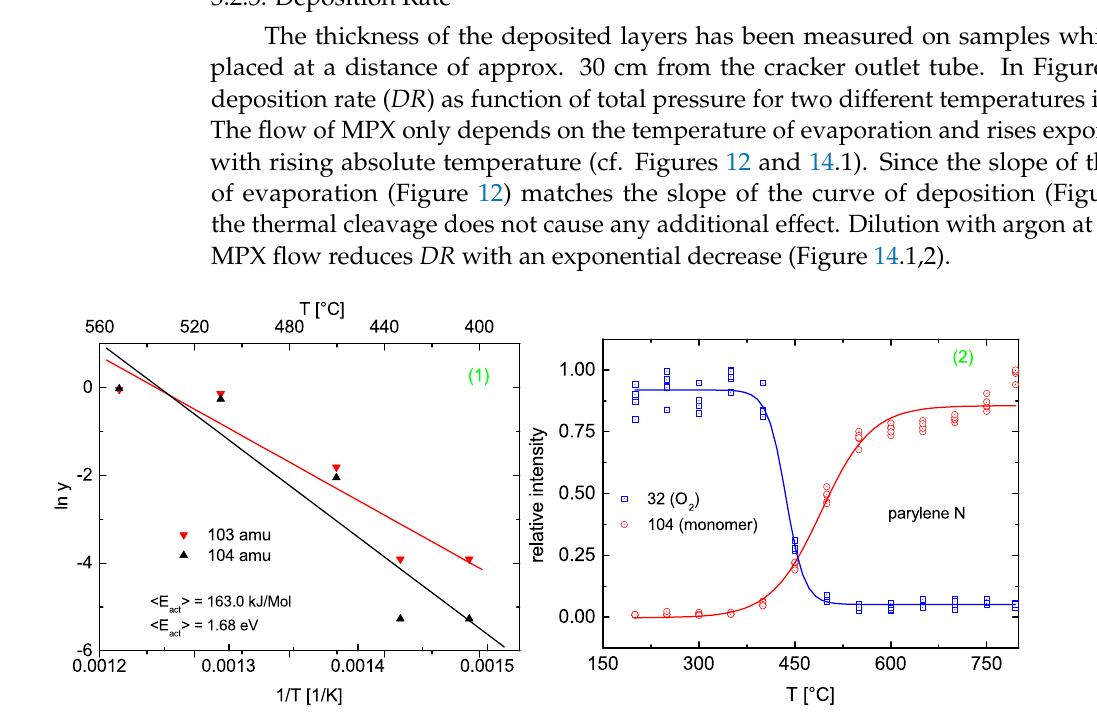
Figure 13. The equilibrium of dissociation [Equation (17)] is evaluated by mass spectrometry. ( 1 ): Arrhenius plot of masses 103 and 104 amu, y ( T ) =